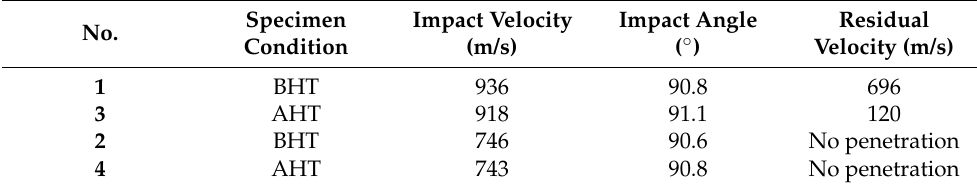
Table 3. Conditions of experimental ballistic